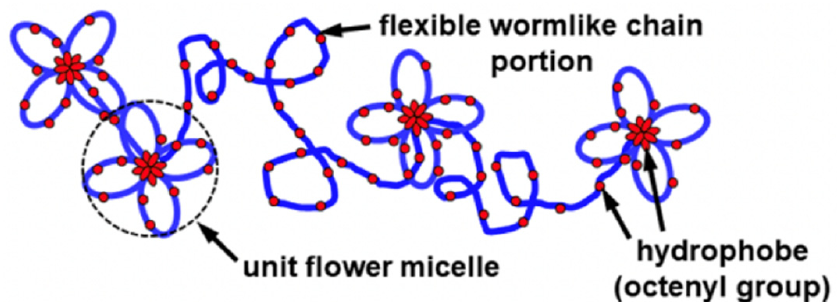
Figure 5. Schematic illustrations of the loose flower necklace model. The unit flower micelle is characterized in terms of the mean radius of the hydrophobic core R core and the height of the minimum loop chain d loop . (The size distribution of the hydrophobic core is characterized by R core and the variance σ 2 [10,11].) Using the wormlike chain statistics, d loop is related to the persistence length q of the polymer chain by